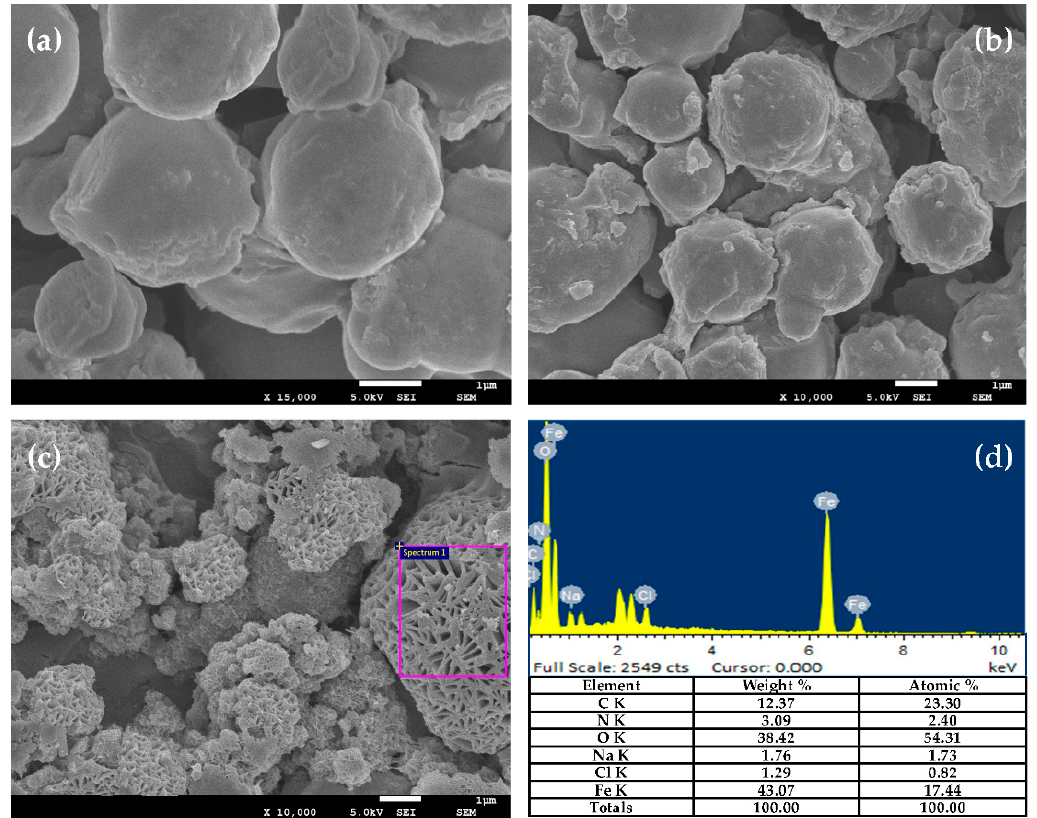
Figure 4. SEM images of ( a ) CI@G particles, ( b ) CI@Fe 3 O 4 @G particles, ( c ) CI@Fe 3 O 4 @G@GO particles, and ( d ) EDS analysis of CI@Fe 3 O 4 @G@GO particles.